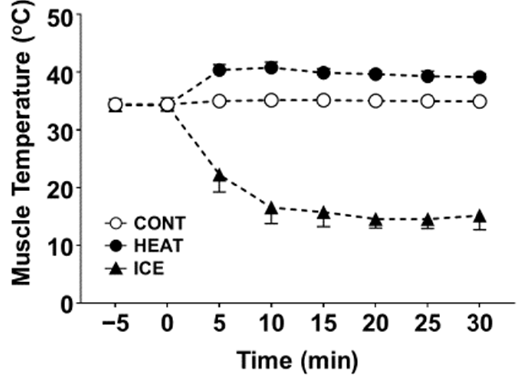
Figure 2. Mean of muscle temperature in each group.